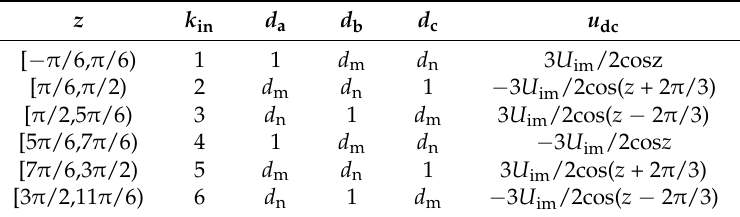
Table 1. The expression of d a , d b , and d c when I ref in diffirent vectors.